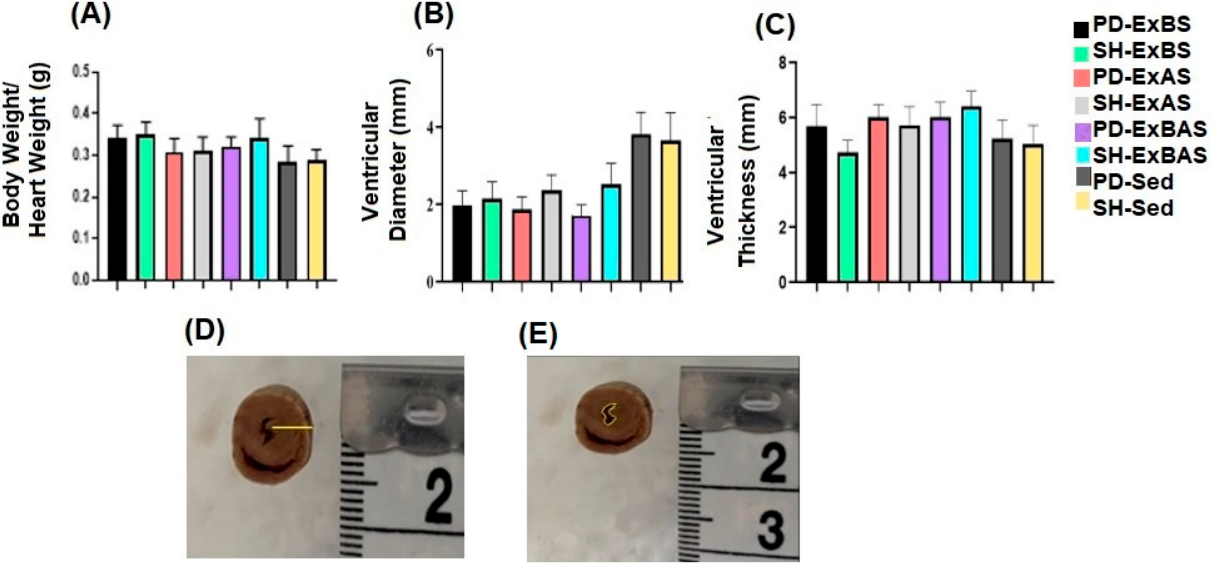
Figure 6. Morphometric analysis of the heart: ( A ) mean ratio of body weight to heart weight, ( B ) diameter of the left ventricle, and ( C ) thickness of the left ventricle. Photomicrograph of ( E ) diameter of the left ventricle in the PD-ExBAS group and ( D ) thickness of the left ventricle in the PD-ExBAS group.